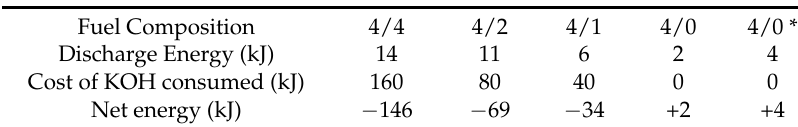
Table 2. Energy analysis for DFFCs (MEA; Pd/C-CeO 2 anode, FeCo/C cathode, AEM A-201 (T cell 60 ◦ C). * MEA with ionomer. Table 2. Energy analysis for DFFCs ( MEA ; Pd/C-CeO 2 anode, FeCo/C cathode, AEM A-201 (T cell 60 °C). * MEA with ionomer.